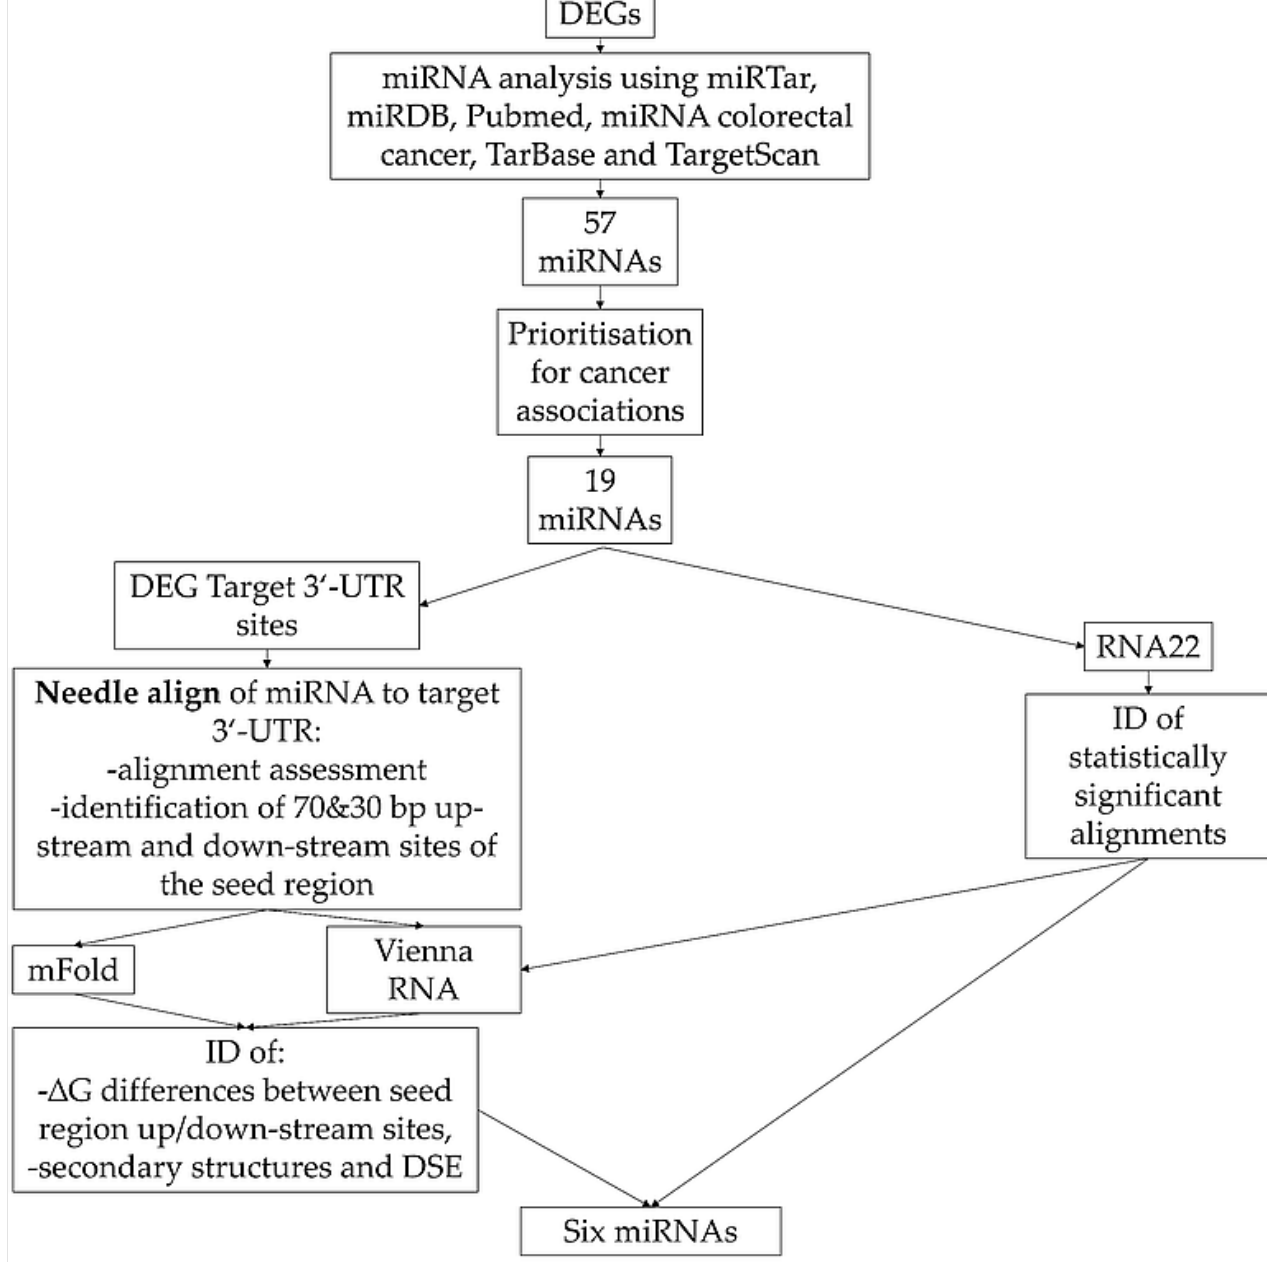
Figure 1. Identification and prioritization of miRNAs. Legend: DEG, differentially expressed genes; DSE, destabilising elements; Δ G, minimum free energy; ID, identification.